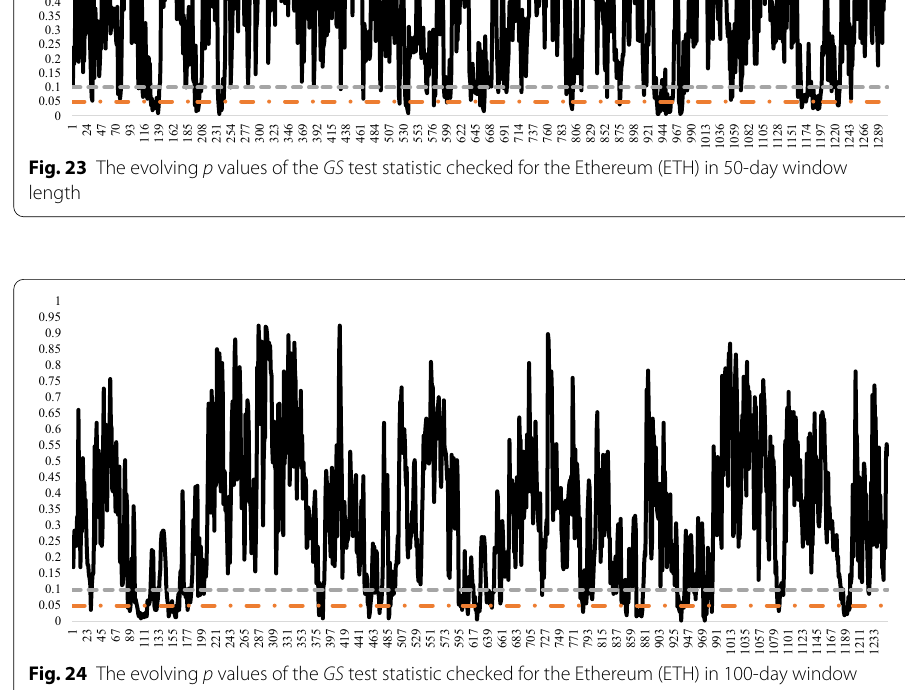
Fig. 24 The evolving p values of the GS test statistic checked for the Ethereum (ETH) in 100-day window length